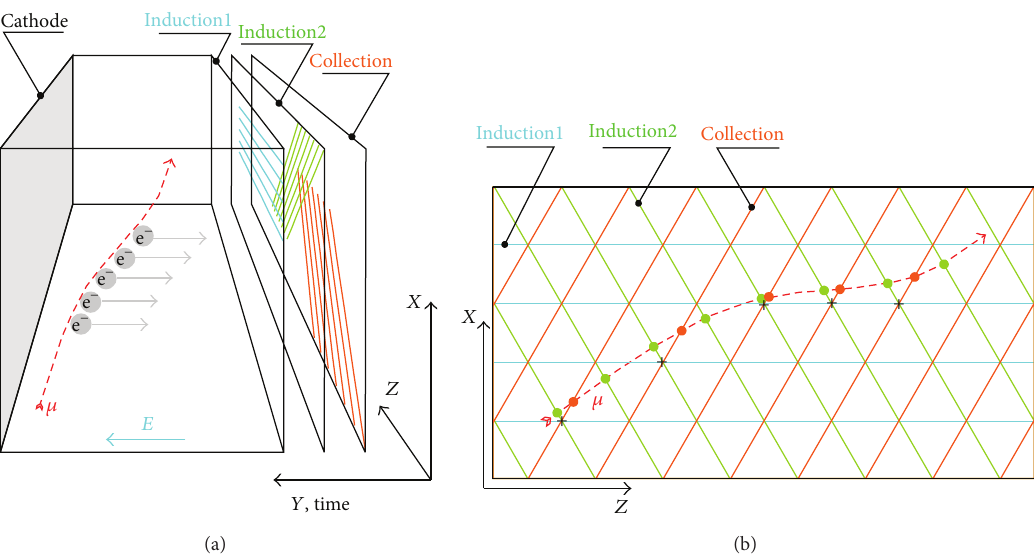
Figure 1: Schematic view of the ICARUS T600 readout principle; one of four TPCs is shown: (a) 3D view with marked 𝜇 track and the ionization electrons e − drifting in the electric field 𝐸 toward the readout wire planes; (b) the XZ projection with marked actual intersections of the particle track and readout wires (green and orange points) and an example of points on the reconstructed track that may be obtained by associating wire signals from Induction2 and Collection planes using drift timing (black